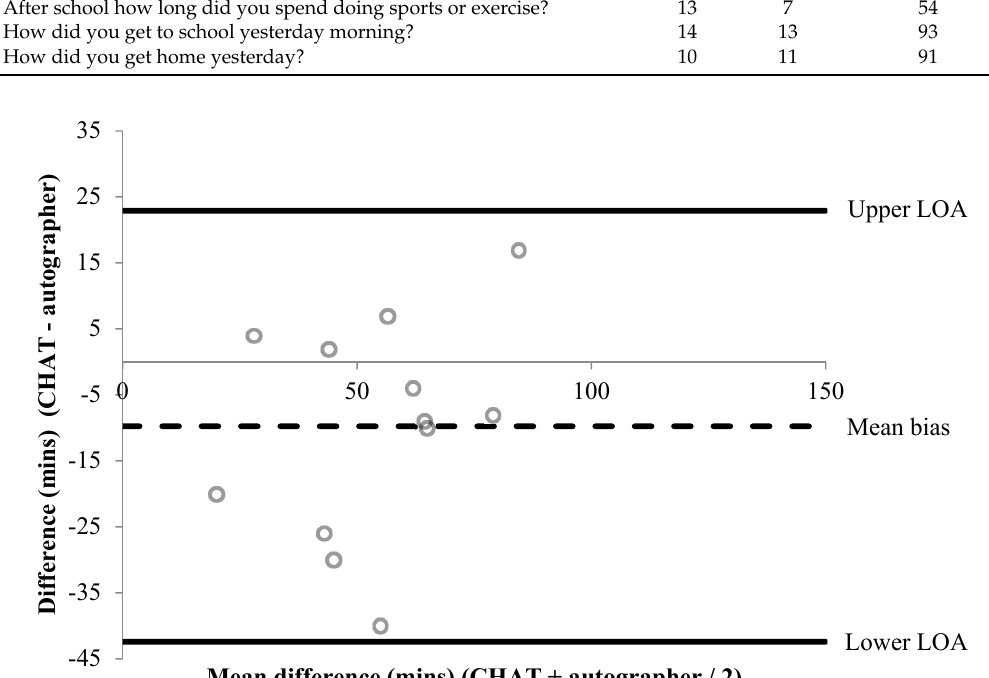
Figure 1. A Bland–Altman plot demonstrating the difference between self-reported and autographer- derived getting up time ( n = 12). A mean bias of − 10 min ( ± 17 min) with limits of agreement (LOA) of +23 and − 42 min is shown.